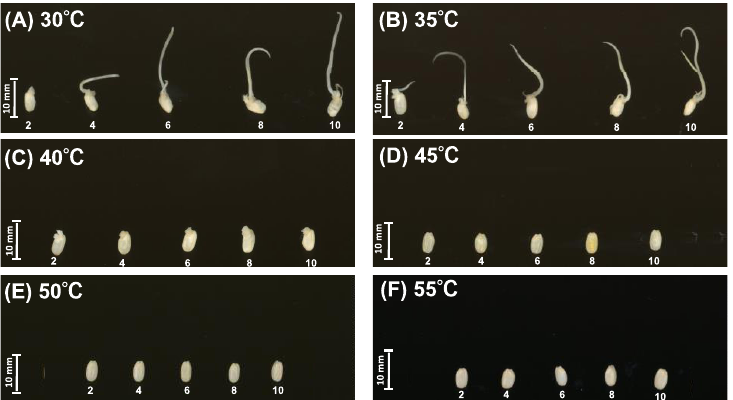
Figure 1. Effect of temperature on germination. ( A ) 30 °C, ( B ) 35 °C, ( C ) 40 °C, ( D ) 45 °C, ( E ) 50 °C, and ( F ) 55 °C.